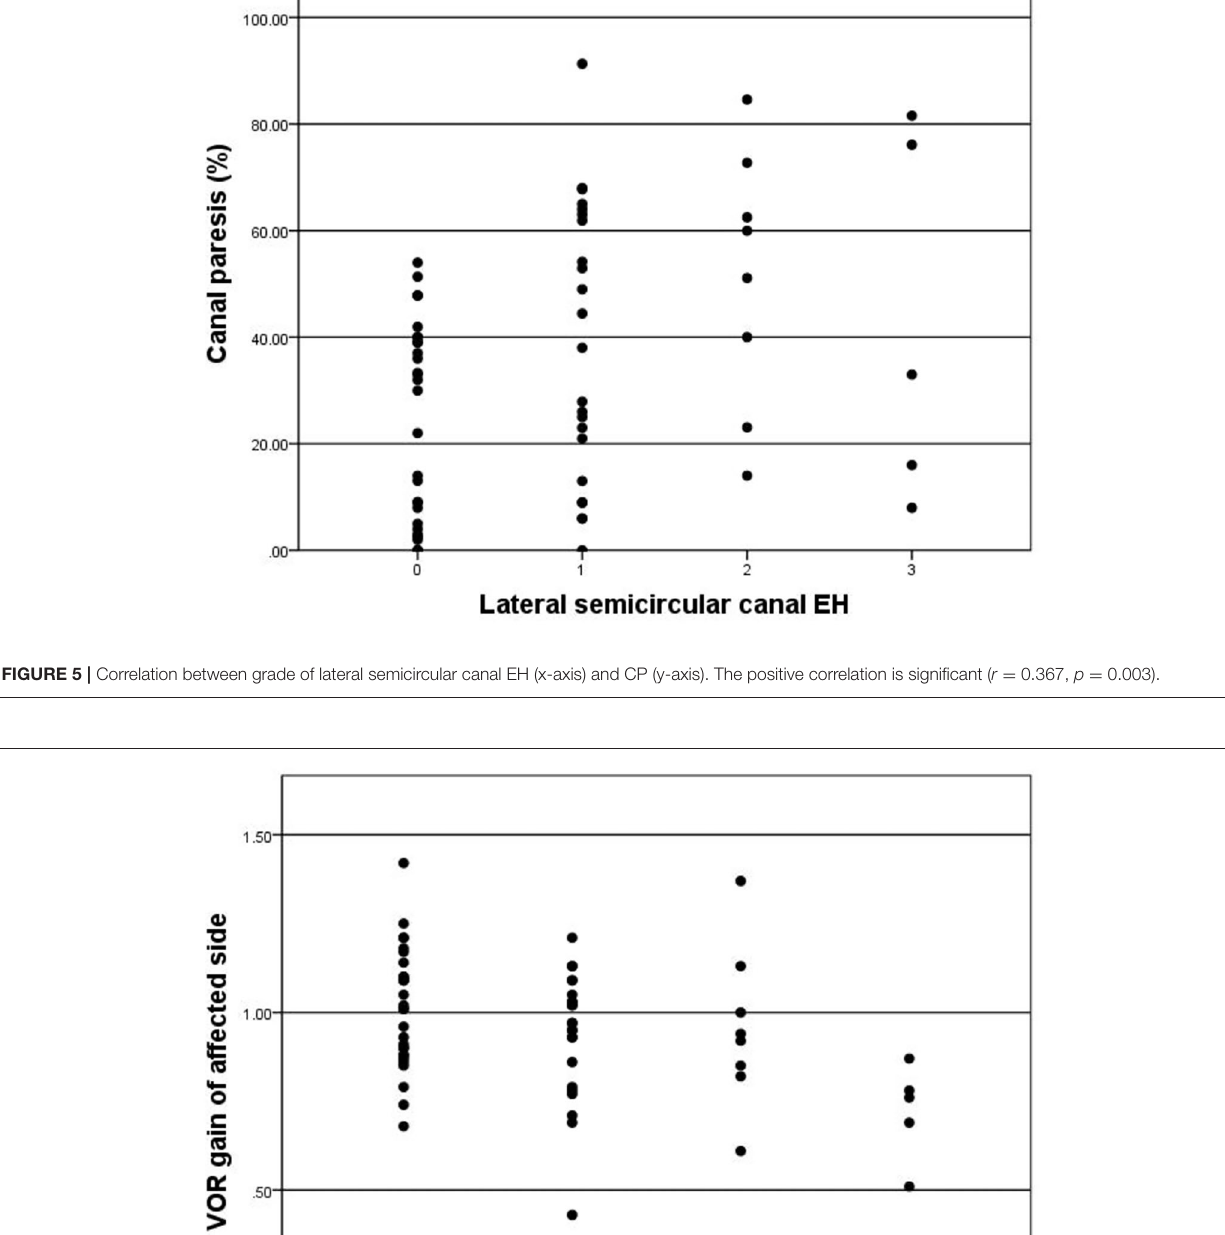
Frontiers in Surgery |